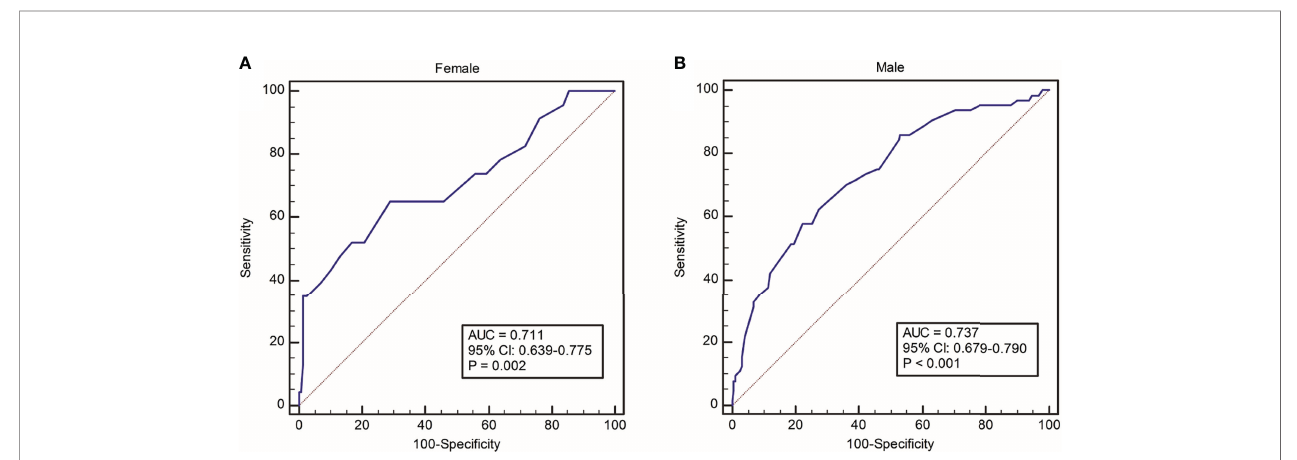
FIGURE 2 | ROC analysis on discriminative power of PEF for predicting risk of PPCs in (A) female and (B) male groups.